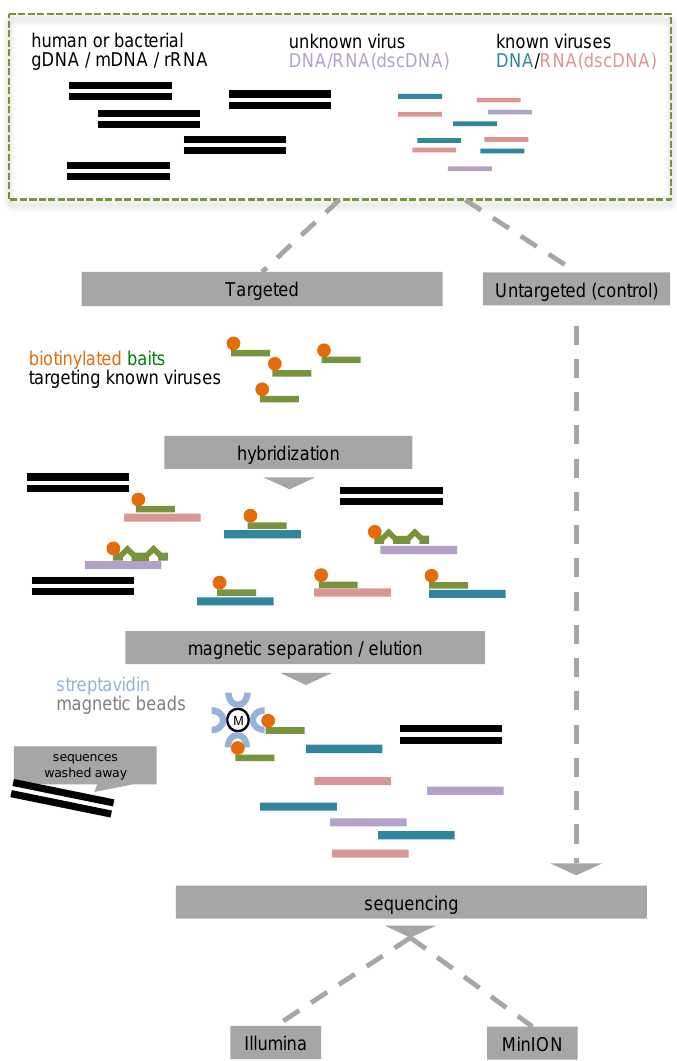
Figure 1. Schematic representation of the study design. Targeted virome library preparation enriches both DNA and RNA viruses as well as unknown viruses (in pink) due to the partial hybridization of the molecular baits (green—orange) to the viral genomes. Targeted and untargeted (control) libraries are sequenced in parallel.